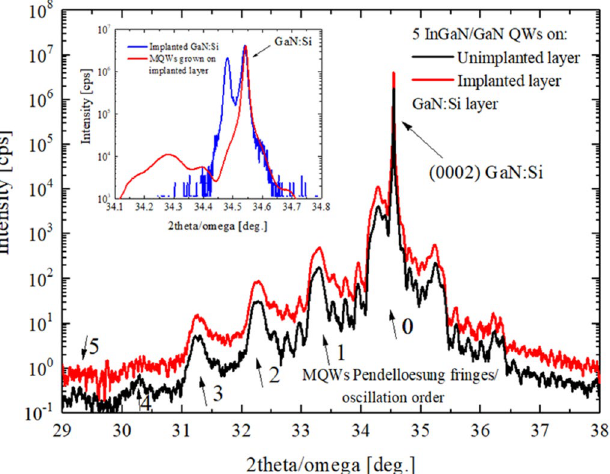
Figure 8. Comparison of HRXRD 2theta/omega scans of the MQWs grown on unimplanted (black line) and implanted GaN:Si layer (red line). Insert: comparison of the diffraction pattern of implanted GaN:Si (blue line) to the same layer with MQWs grown on it.